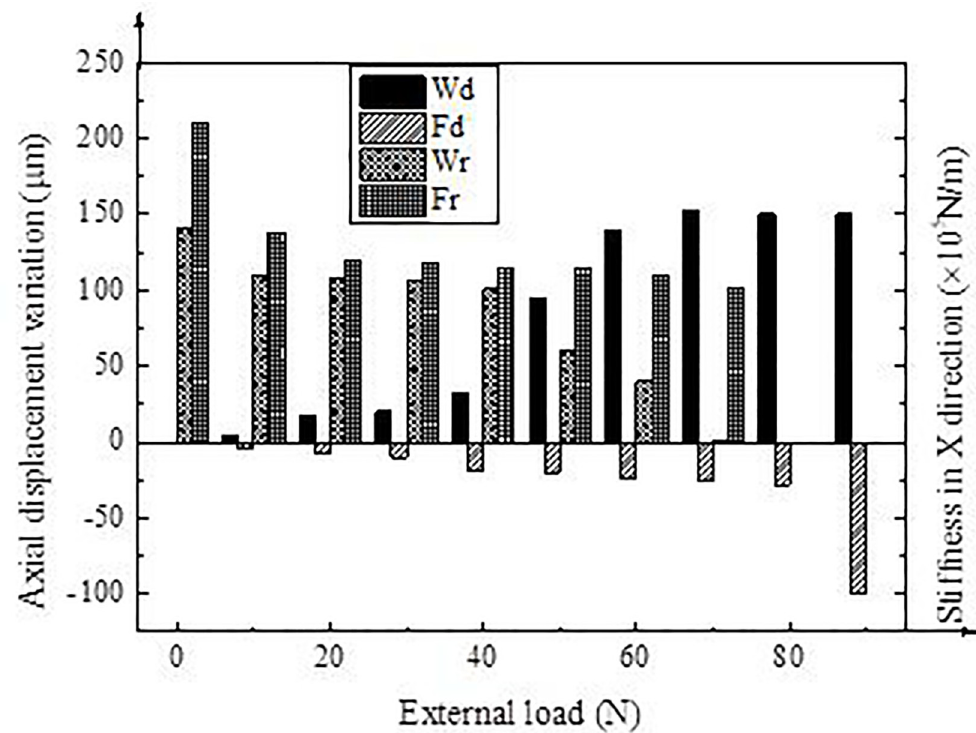
Fig 5. Displacement and stiffness changes based on different external loads (In the figure, Wd represents the axial displacement change at the radial bearing on the working wheel side, Fd represents the axial displacement change at the radial bearing on the fan wheel side; Wr represents the stiffness change in X direction of the radial bearing on the working wheel side, and Fr represents the stiffness change in the X direction of the radial bearing on the fan wheel